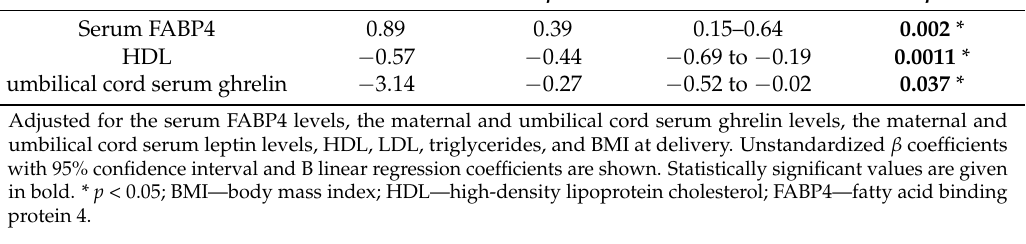
Table 3. Multiple linear regression analyses for the umbilical cord serum FABP4 levels.